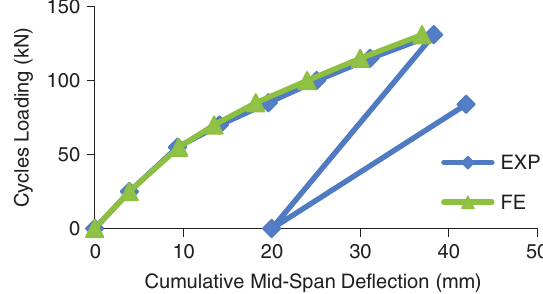
Fig. 18. Load against cumulative Mid-Span defalcation for the post-repair phase of the beam G3R2